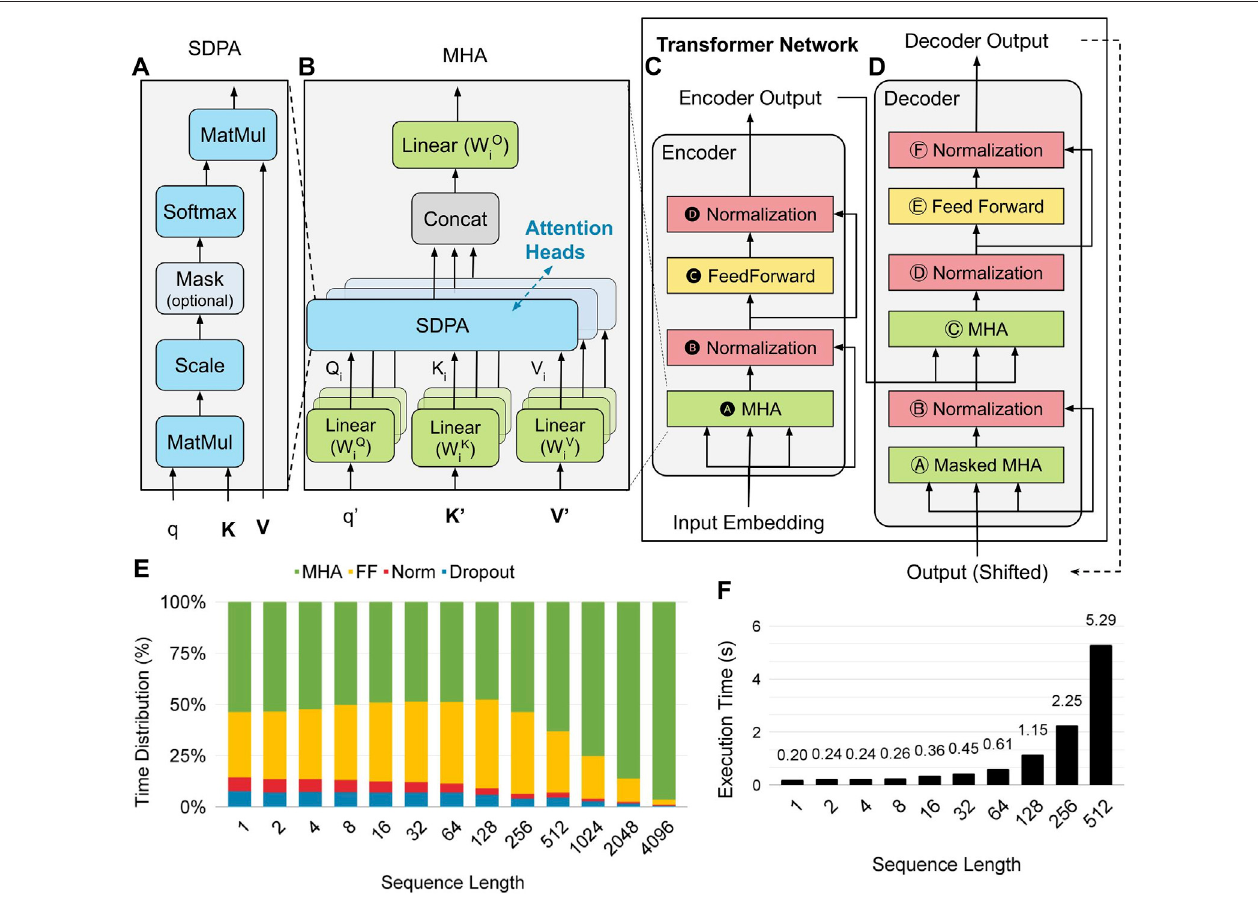
FIGURE 1 | Transformers use scaled dot product attention (A) and multi-head attention (B) to model long-range dependencies and use an encoder-decoder architecture (Vaswani et al., 2017). The encoder (C) and decoder (D) layers are composed of multihead attention, feedforward and normalization sublayers. The executiontimedistribution (E) showsthetransformernetworksbecomesmoredominatedbythemulti-headattentionassequencelengthincreases.Theexecutiontime (F) of transformers increases as the sequence length increases.